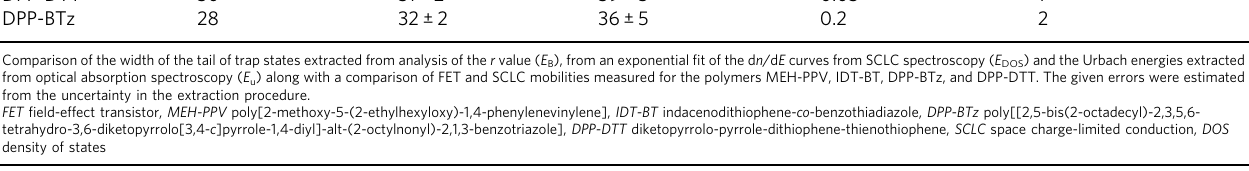
Table 1 Comparison of electronically and optically measured DOS Polymer